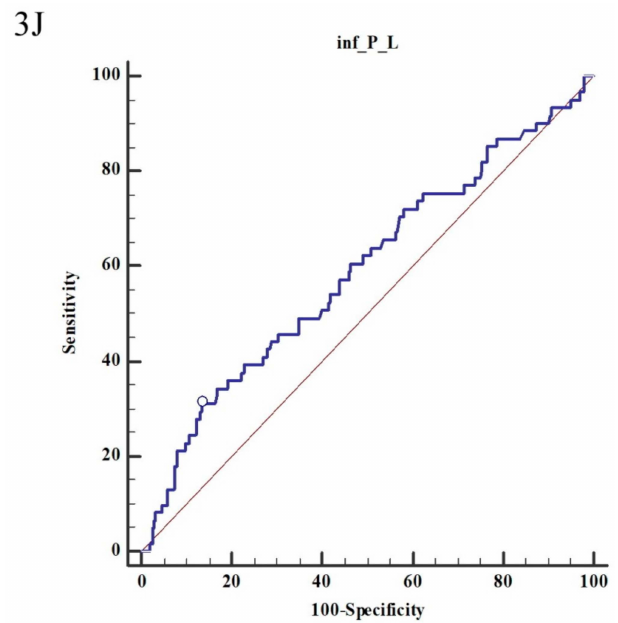
Figure 3. Predicting renal survival of IgA nephropathy with IgA level, C3 level, IgG level, ratio of neutrophil / lymphocyte, and ratio of platelet / lymphocyte, and Kaplan–Meier curve. ( 3A ) Renal survival between IgA ≤ 350 or > 350 mg / dL without significance. ( 3B ) IgA ≤ 350 mg / dL did not predict worse renal survival with poor power (AUC = 0.550 sensitivity = 72.73%, specificity = 41.37%). ( 3C ) Renal survival between C3 ≤ 79.7 mg / dL or > 79.7 mg / dL di ff ered significantly. ( p = 0.001). ( 3D ) C3 ≤ 79.7 mg / dL predicted worse renal outcome with fair power. (AUC = 0.587, sensitivity = 22.81%, specificity = 94.96%). ( 3E ) Renal outcome in IgG ≤ 907 or > 907 mg / dL di ff ered significantly ( p = 0.002). ( 3F ) IgG ≤ 907 mg / dL predicted worse renal survival with fair power (AUC = 0.596, sensitivity = 42.59%, specificity = 77.22%). ( 3G ) Neutrophil-to-lymphocyte ratio > 2.75 predicted worse renal survival ( p < 0.001). ( 3H ) Neutrophil-to-lymphocyte ratio > 2.75 predicted worse renal outcome with good power. (AUC = 0.696, sensitivity = 73.33%, specificity = 62.17%). ( 3I ) Platelet-to-lymphocyte ratio > 16.06 predicted worse renal survival significantly ( p = 0.010). ( 3J ) Platelet-to-lymphocyte ratio > 16.06 predicted worse renal survival with fair power (AUC = 0.590, sensitivity = 31.15%, specificity =